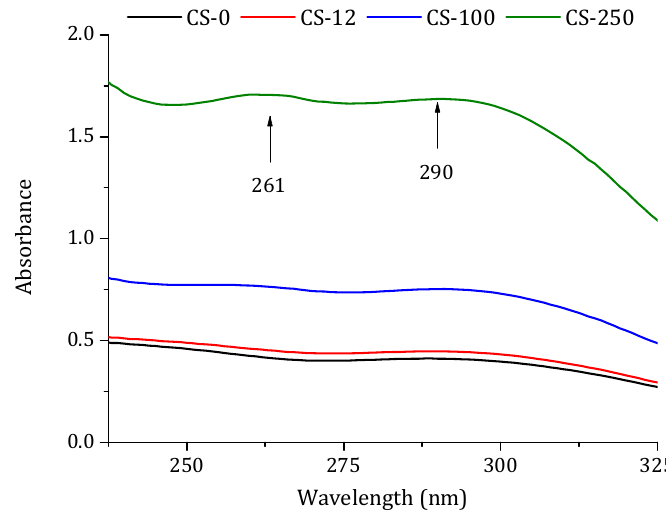
Figure 4. Absorption spectra of chitosan: non-irradiated (CS-0) and irradiated at different doses in solid state, 12.5 kGy (CS-12), 100 kGy (CS-100), and 250 kGy (CS-250). Measurements were taken for 1% ( w/w ) chitosan solution in 2% ( w/w ) acetic acid.